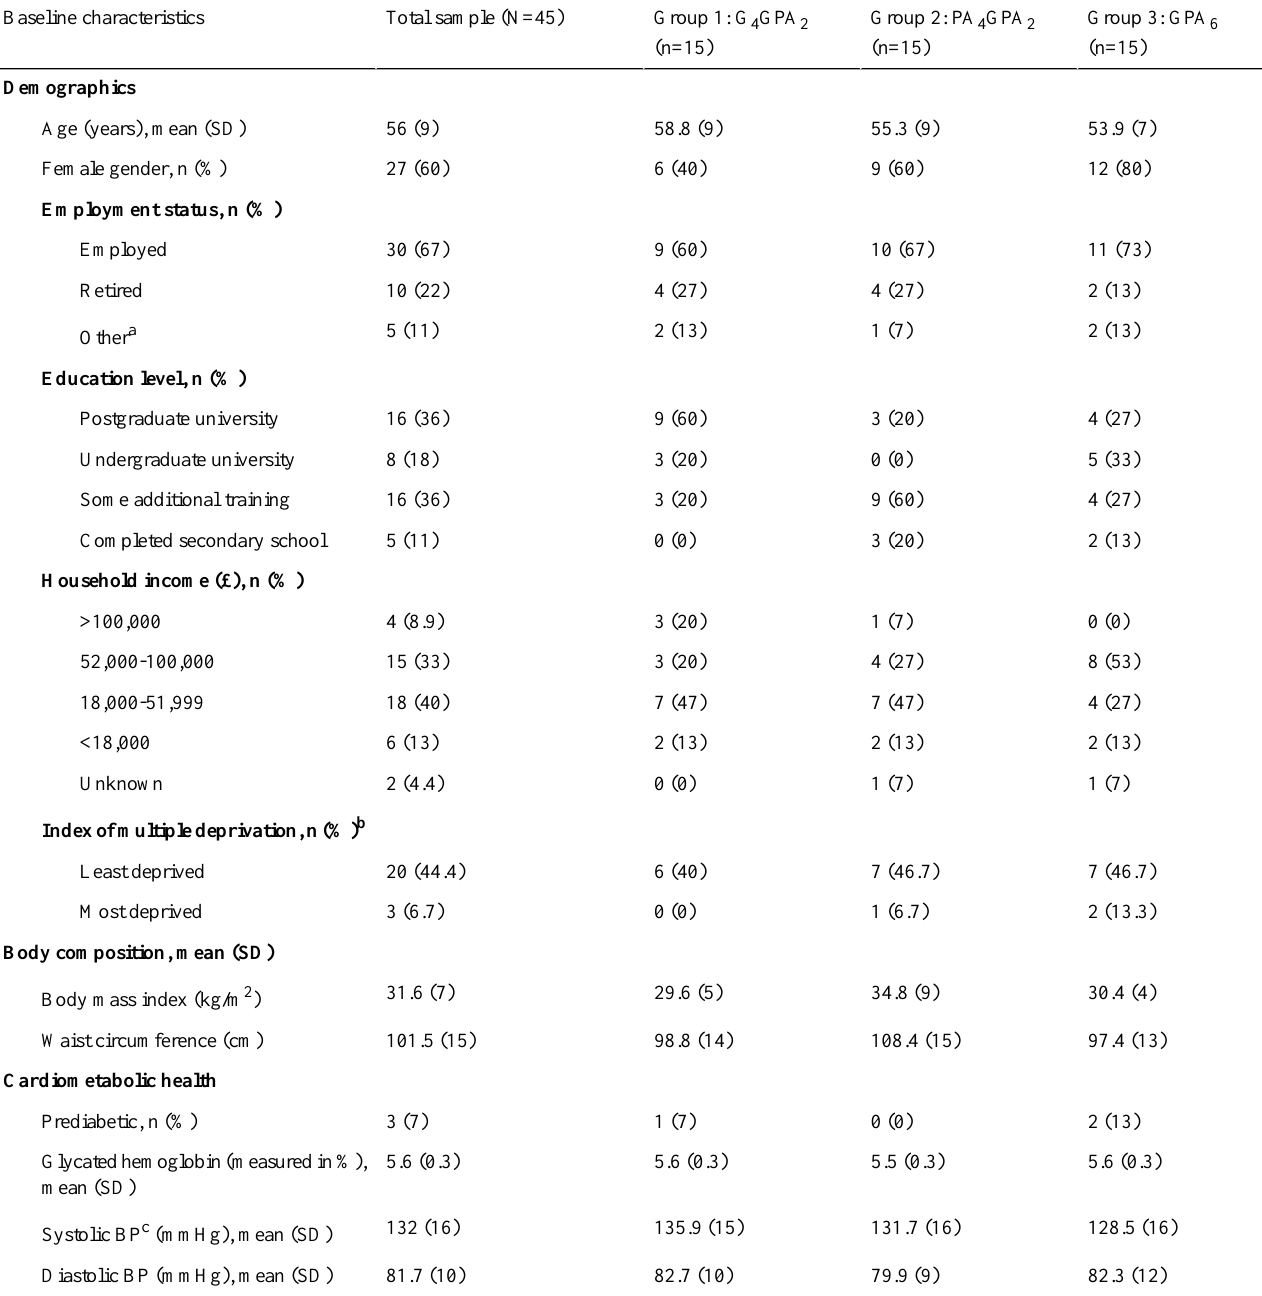
Table 1. Participants’baseline characteristics stratified by group.